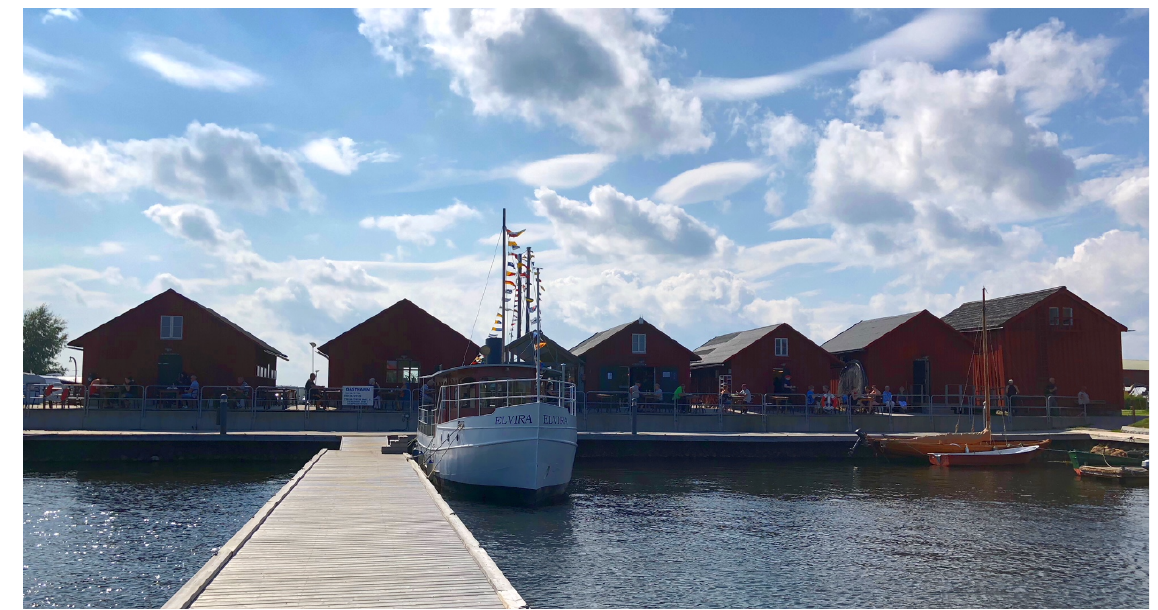
Figure 2. The Western Dock in Piteå (photographer Johanna Balogh). by a boat café, kayak rentals, accommodation in one of Piteå’s oldest buildings from the 16th century, as well as recurring flea-markets, auctions, and cultural